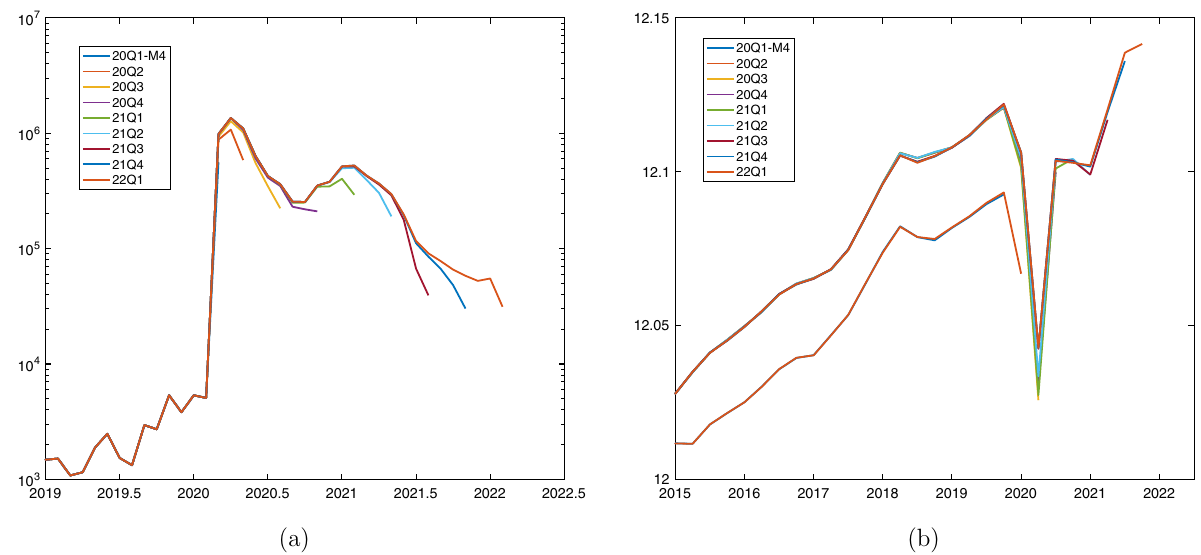
Fig. 3 Time series vintages. a Short-time workers. Monthly frequency, logarithmic scale, observed up to March for forecasting start date 2020Q1-M4 (end April) and end of quarter’s second month for all other forecasting start dates. b Log real GDP, quarterly frequency, observed up to the lagged quarter of the forecasting start date (also 2019Q4 for start date 2020Q1-M4). Notes: Short-time workers, concatenated data: Published pdf-file (https:// www. seco. admin. ch/ seco/ de/ home/ Arbeit/ Arbei tslos enver siche rung/ leist ungen/ kurza rbeit sents chaed igung. html) as of May 1, 2020, January 2000–December 2003; download (https://www.amstat.ch/MicroStrategy/servlet/mstrWeb) as of May 25, 2022, January 2004 to February 2022. Vintages constructed from April 2020 to April 2022 using data on short-time workers with settled payments after one to seven months following the settlement period. GDP growth: Download (https:// www. seco. admin. ch/ seco/ de/ home/ wirts chaft slage —wirts chaft spoli tik/ Wirts chaft slage/ bip- quart alssc haetz ungen-/ conce pts–en–. html) as of May 28,